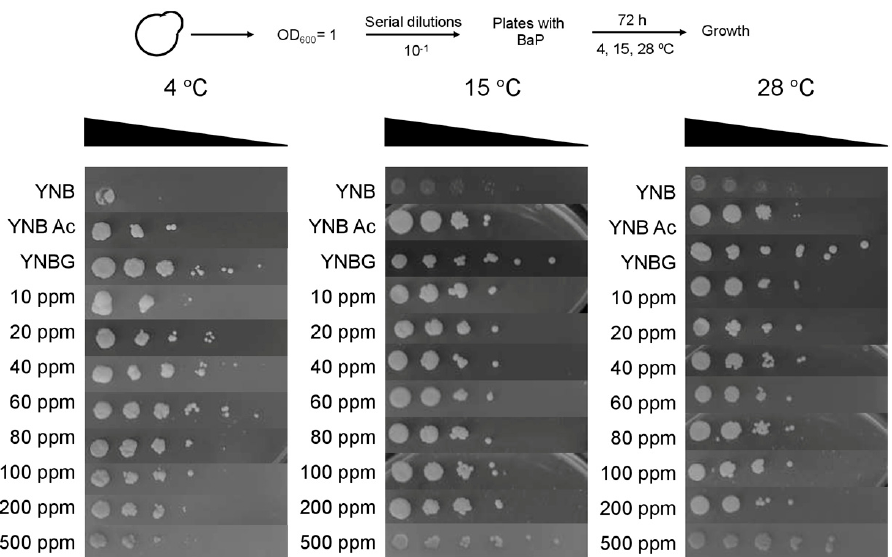
Figure 3. Effect of different benzo(a)pyrene (BaP) concentrations and temperatures on D. hansenii growth. Drop tests were performed in YNB medium using BaP as a carbon source. Ten − fold serial dilutions from a yeast suspension adjusted to OD 600 = 1.0 were dropped in plates containing different BaP concentrations as indicated. They were incubated at 4 °C for one month and at 15 and 28 °C for 72 h. Controls: YNB, yeast nitrogen base; YNBG, YNB supplemented with glucose; YNB Ac, YNB containing acetone (the solvent used to solubilize BaP in a volume equivalent to that of the highest concentration). Representative images of three independent experiments are shown.